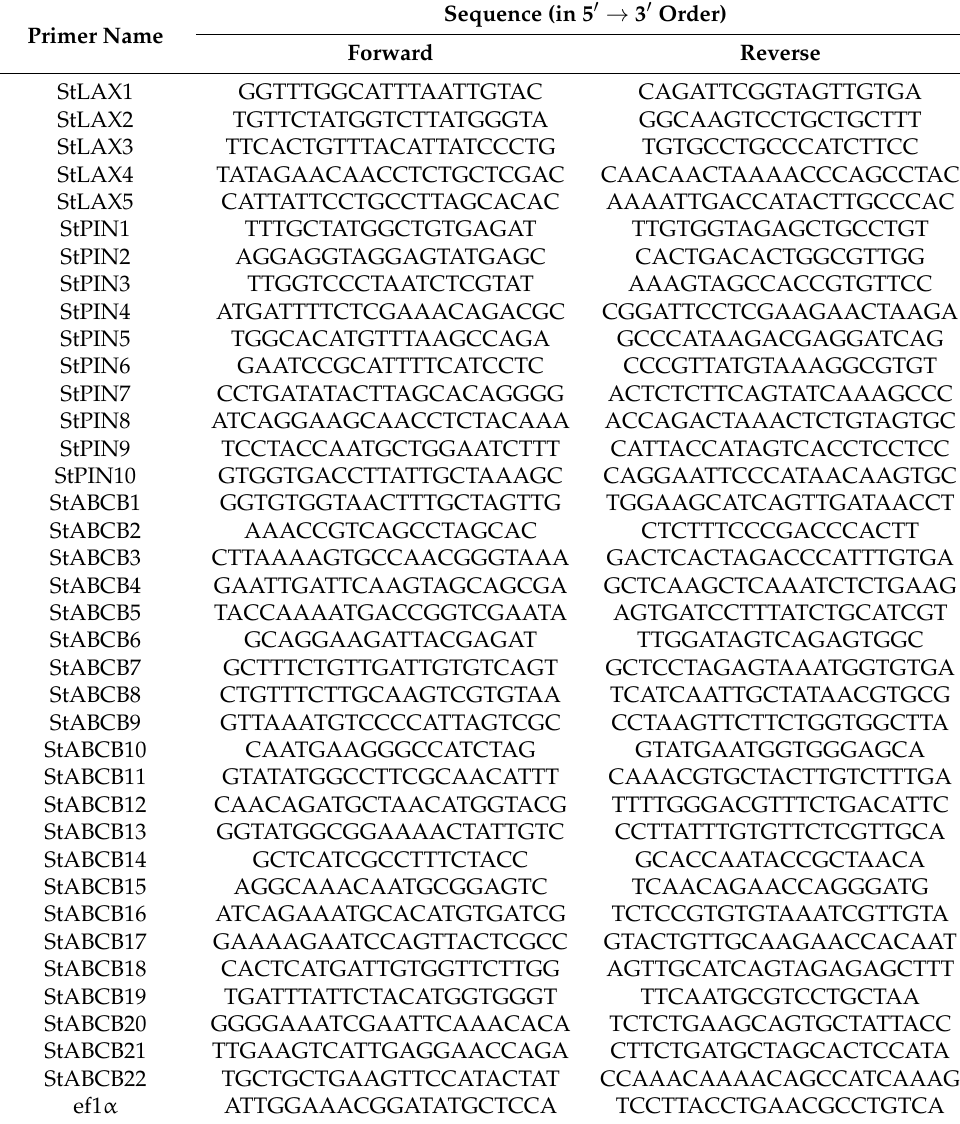
Table A1. The primer sequences used in qPCR analyses.